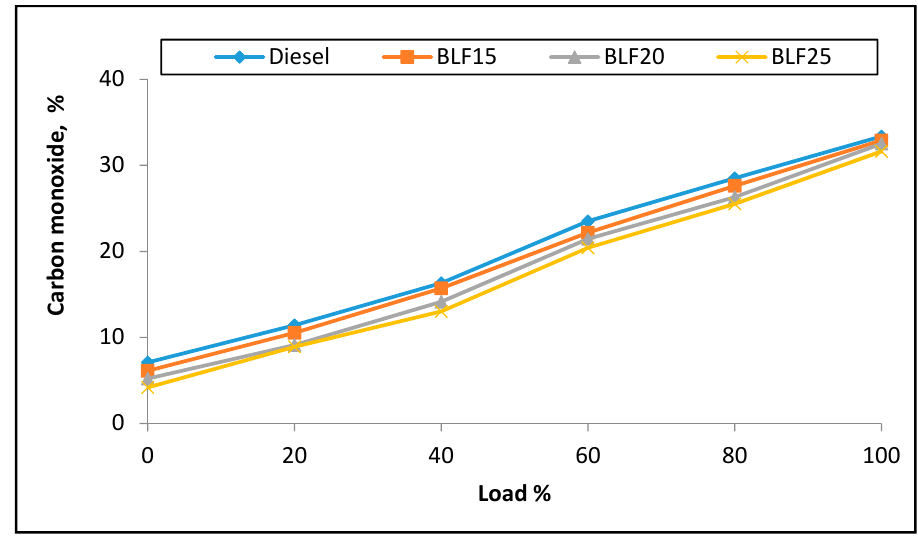
Figure 13. Variations of smoke vs. load percent.